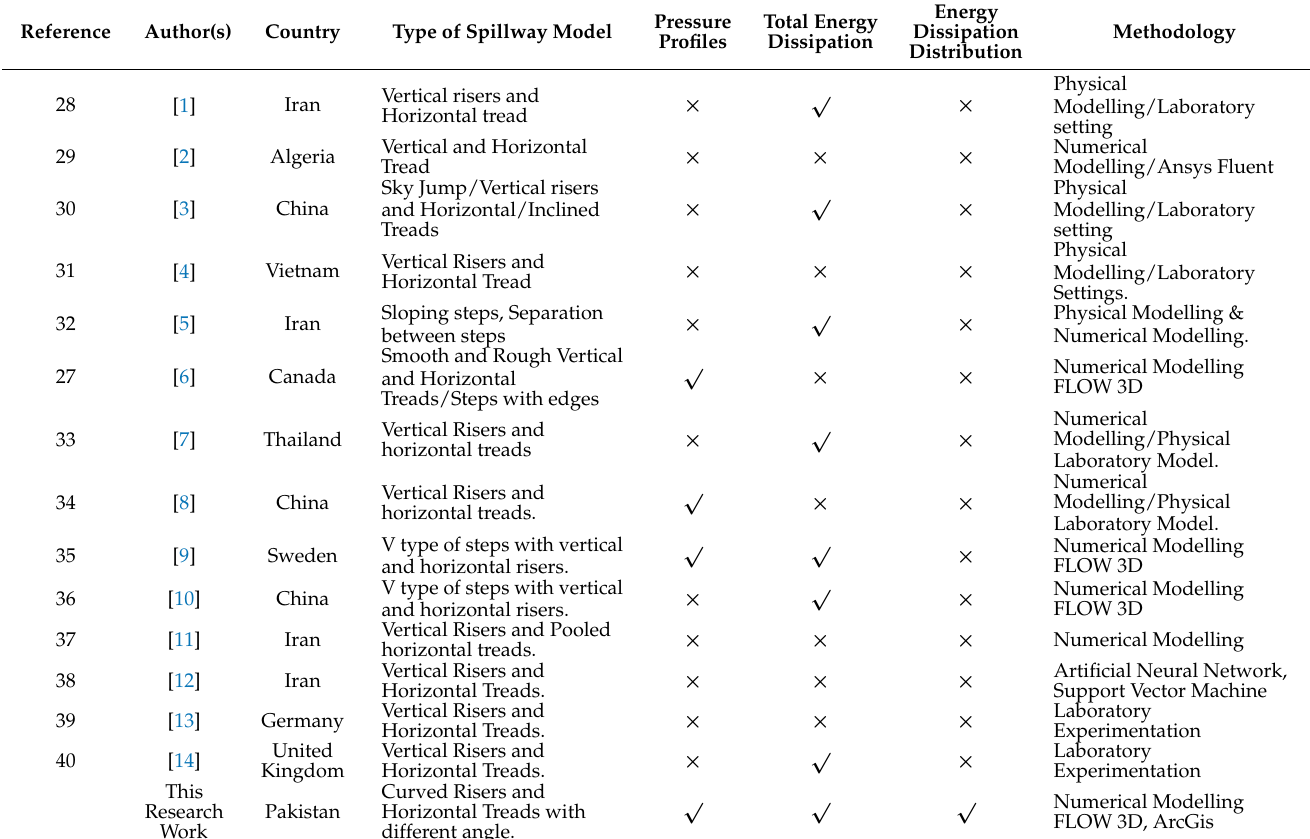
Table 1. Autor study contribution